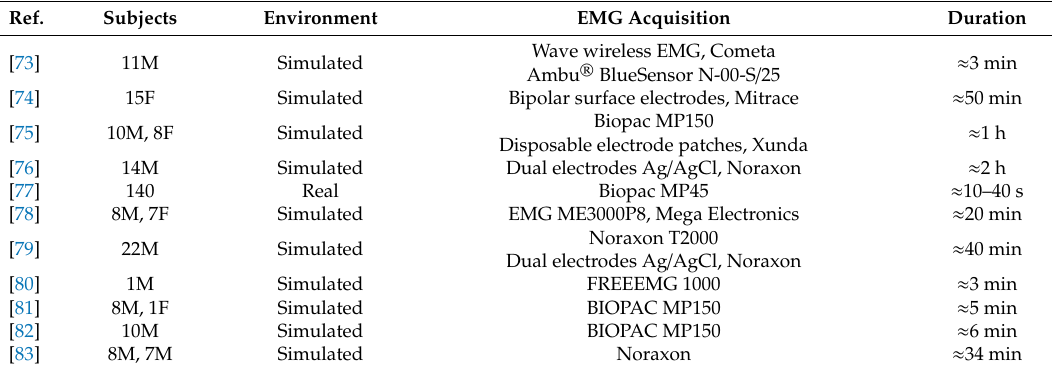
Table 2. Overview of electromyography (EMG) ergonomic assessment experimental setups in production